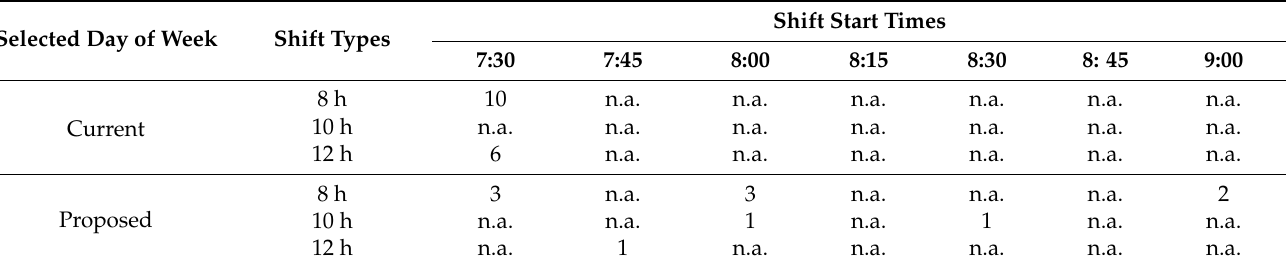
Table 1. Optimal staff schedules for a selected